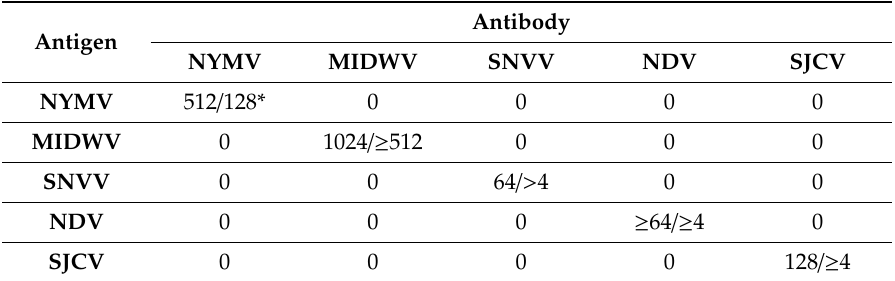
Table 2. Complement fixation tests of San Jacinto virus (SJCV) with Nyamanini (NYMV),